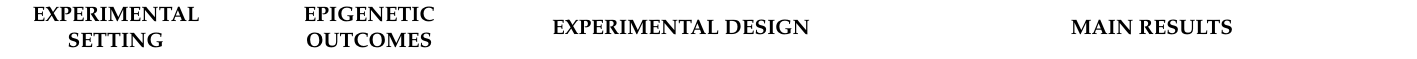
Table 1. Studies addressing epigenetic formaldehyde (FA) e ff ects in humans, animals, and cellular